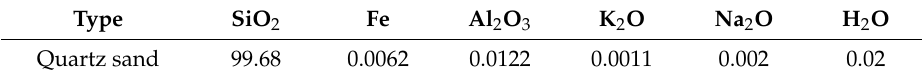
Table 1. Chemical composition of quartz sand (%).